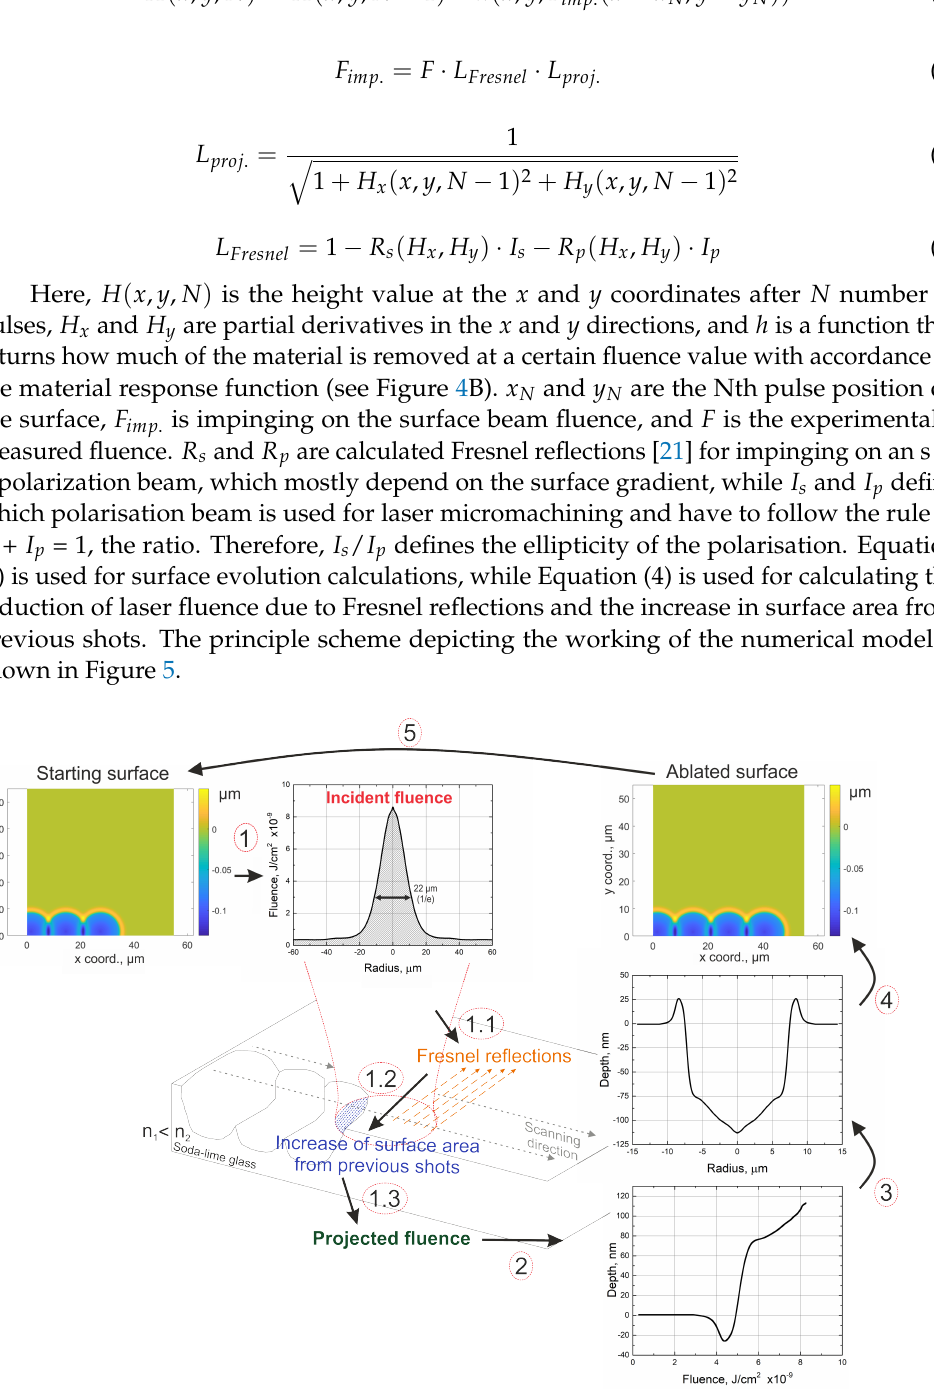
Figure 5. Principle scheme showing the working of the numerical model. The incident fluence is projected on the surface (1). Fluence reduction due to Fresnel reflections (1.1) and increase in surface area from previous shots (1.2) is taken into account. The projected fluence is then calculated (1.3). According to the material response function and projected fluence (2), the ablated volume is calculated (3). Finally, the ablated volume is subtracted from the surface at the current beam location (4). The position of the beam is shifted, and calculations are repeated